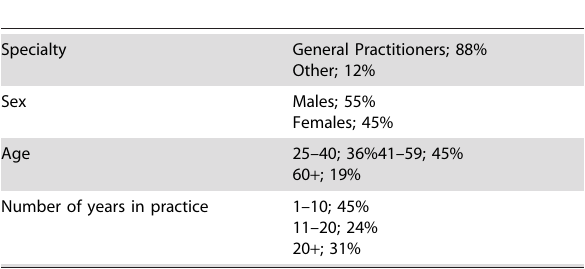
Table 1. Physician Demographic